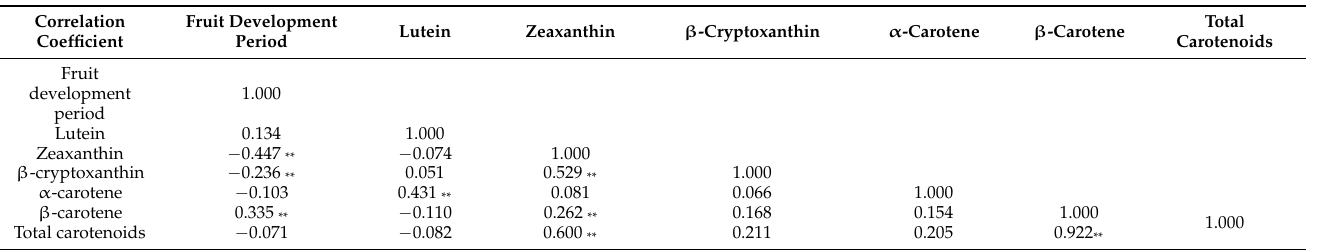
Table 2. Correlation analyses between carotenoids and fruit developmental periods and among carotenoid